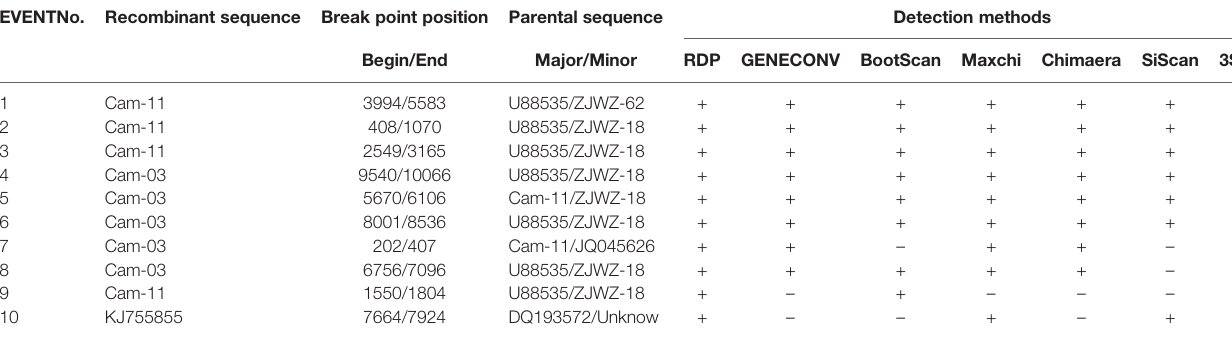
TABLE 4 | Recombination analysis of DENV-1 by RDP package. EVENTNo. Recombinant sequence Break point position Parental